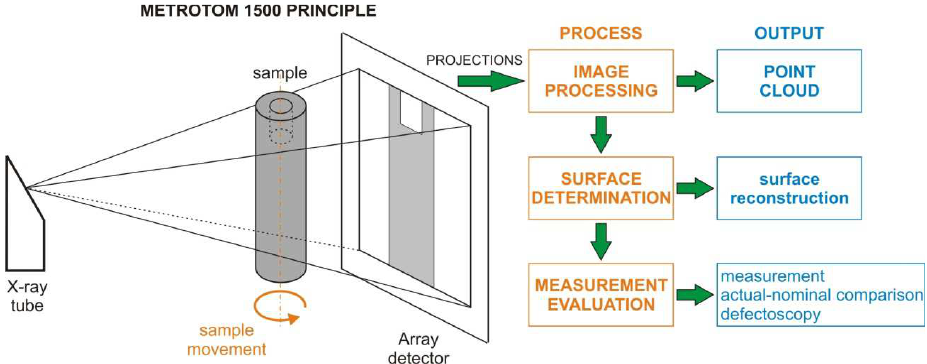
Figure 1 – Metrotom 1500 Principle